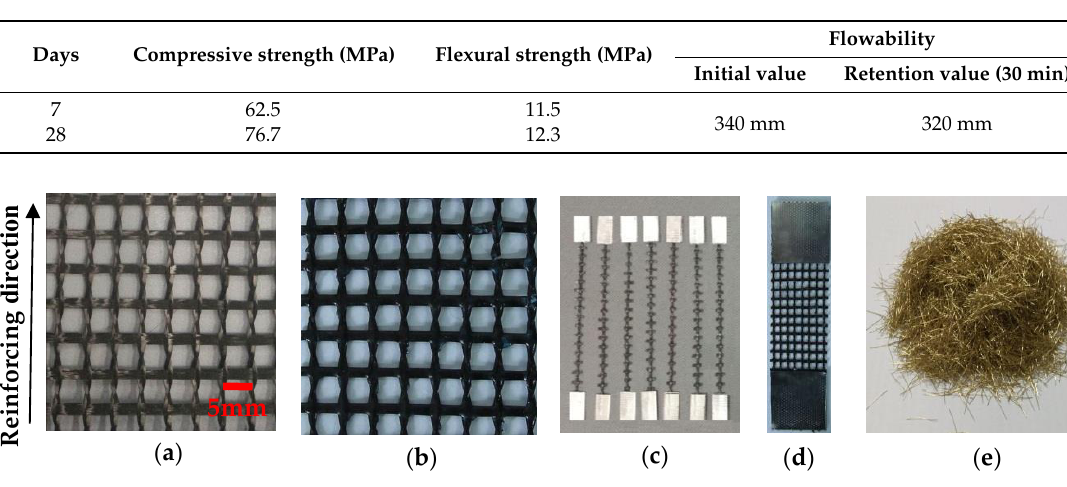
Figure 1. ( a ) Carbon textile; ( b ) impregnated carbon textile; ( c ) single yarn samples; ( d ) carbon textile strip; and ( e ) steel fibres.